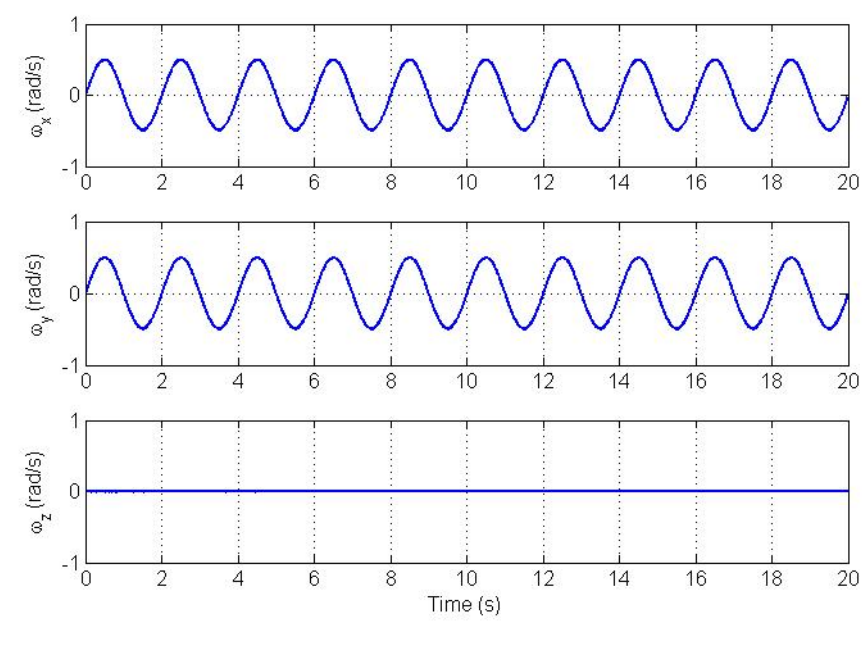
Figure 2. Angular velocity trajectory